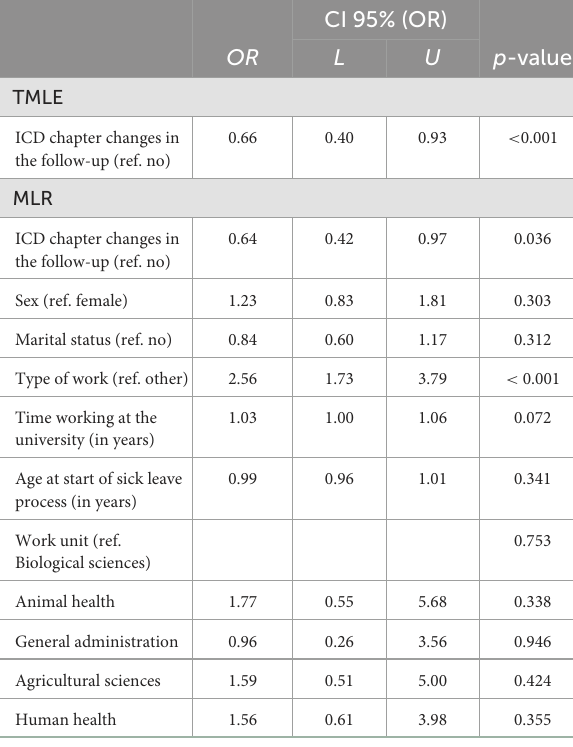
TABLE 2 Predictive models for changes in the ICD-10 chapter and returning to work with readaptation.